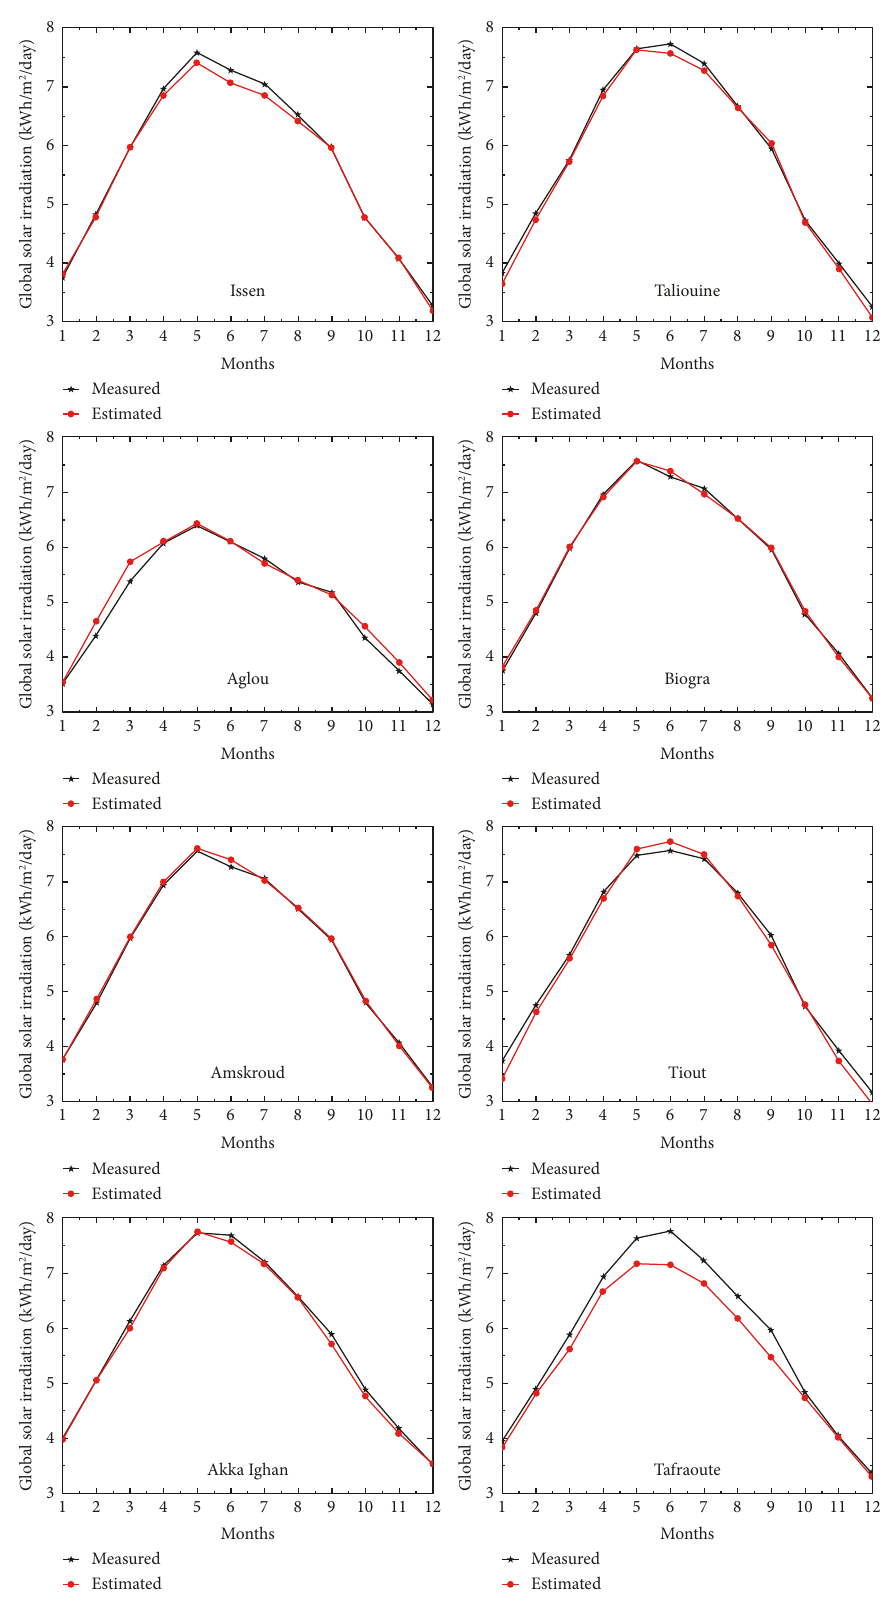
Figure 6: Comparison of the monthly mean global solar irradiation between measured and estimated values for eight locations used in the test under di ff erent climatic conditions during the period 1996 –